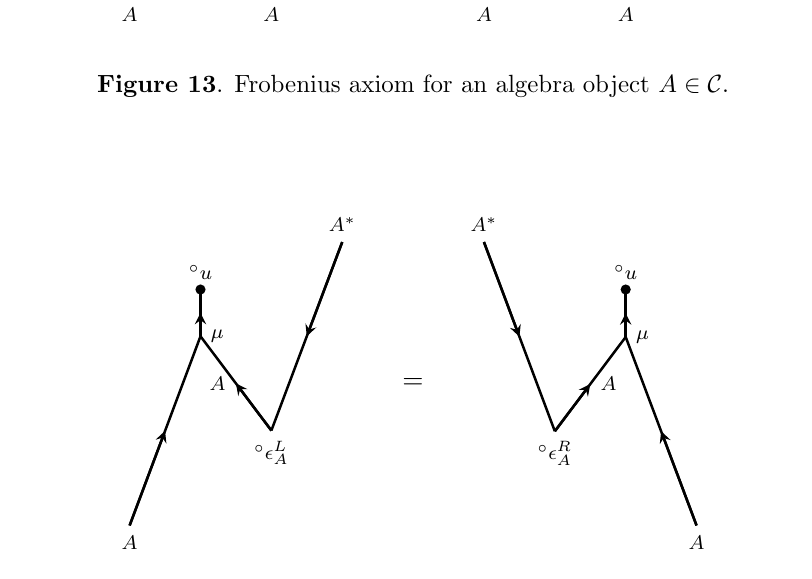
Figure 14 . Symmetricity axiom for an algebra object A 2 C . Here (cid:14) (cid:15) a denotes the co-evaluation map for line a .